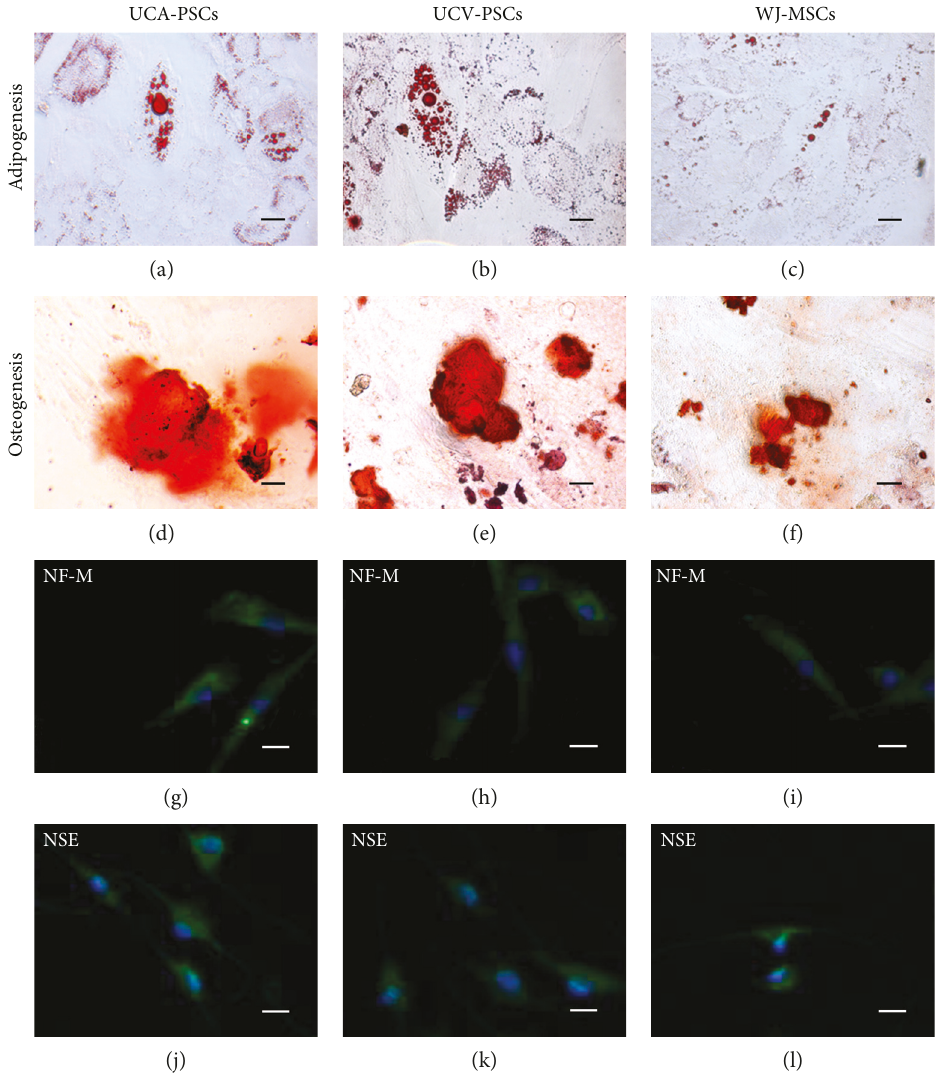
Figure 4: Di ff erentiation of umbilical cord artery perivascular stem cells (UCA-PSCs), umbilical cord vein perivascular stem cells (UCV-PSCs), and Wharton ’ s jelly mesenchymal stem cells (WJ-MSCs). (a – c) For adipogenic di ff erentiation, the cells were cultured in adipogenic induction medium for 14 days. The formation of lipid droplets was con fi rmed by oil red O staining. (d – f) Cells were cultured in osteogenesis induction medium for 21 days. Calcium deposition was con fi rmed by alizarin red staining. (g – l) Di ff erentiation of cells to neuronal lineage after 18 h preinduction and 36h induction was con fi rmed by immuno fl uorescence staining of neuro fi lament medium polypeptide (g – i) and neuron-speci fi c enolase (j – l). Bar: 10 μ